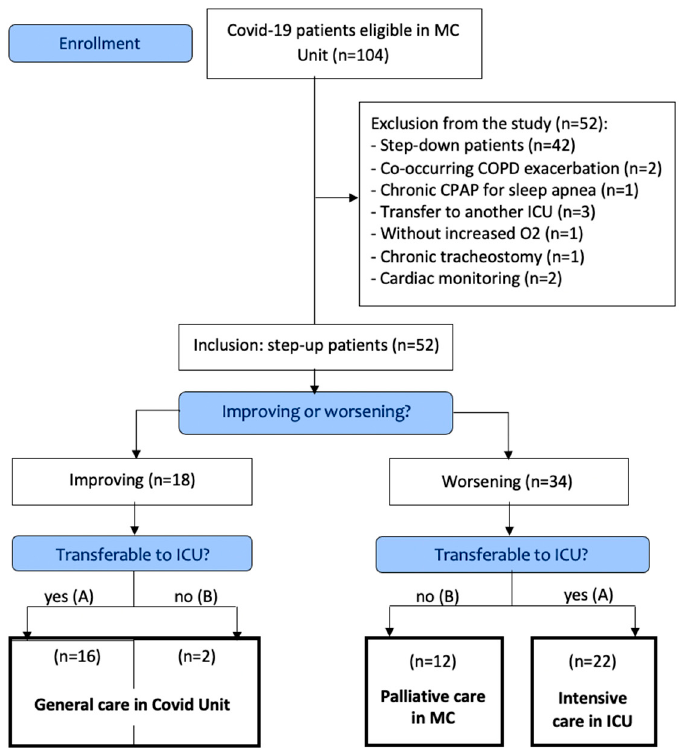
Figure 1. CONSORT Flow diagram of the allocation of the patients.